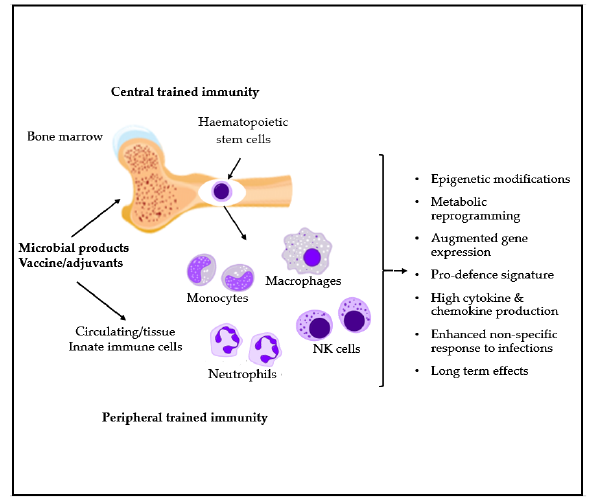
Figure 3. Microbial-derived products as well as some inactivated or attenuated microbial products are suggested to promote the innate immunity training both at peripheral and central level in the bone marrow on HSC (hematopoietic stem cells). This involves epigenetic modifications, modified gene expression, metabolic reprogramming and a pro-defense signature characterized by increased chemokines and cytokines production